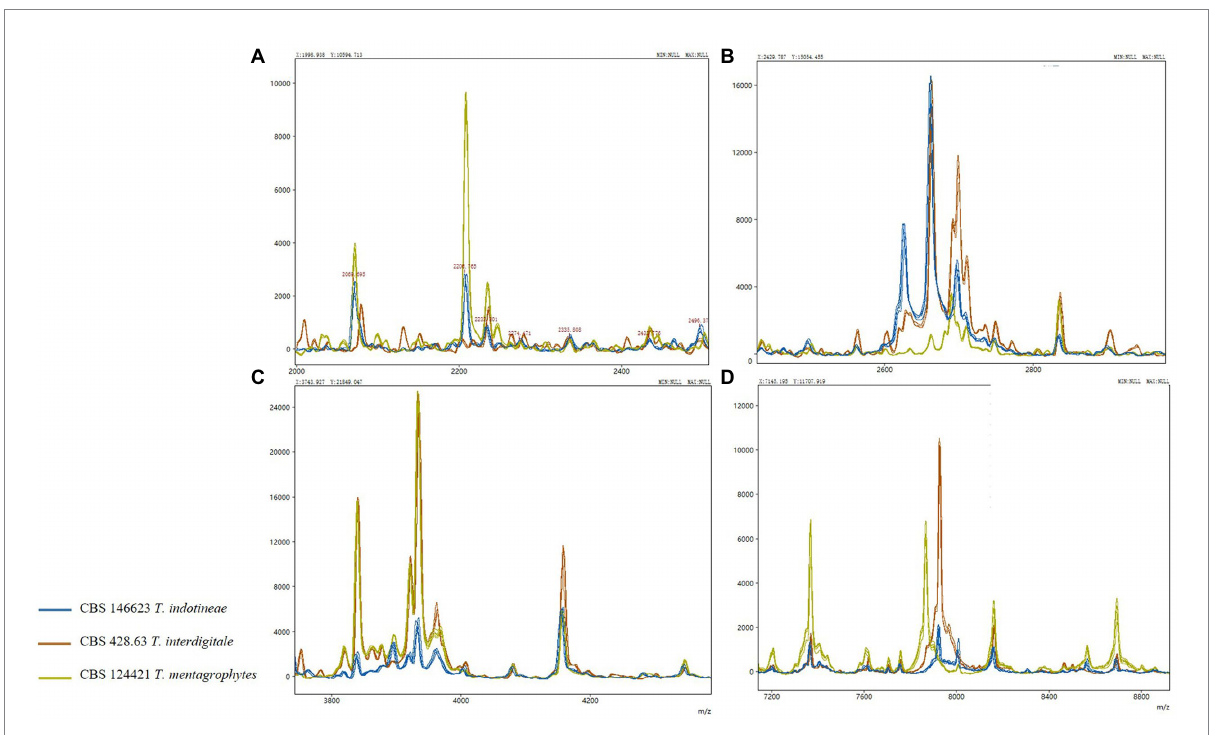
FIGURE 2 MALDI-ToF MS in the T. mentagrophytes species complex; only variable regions are shown in (A–D)